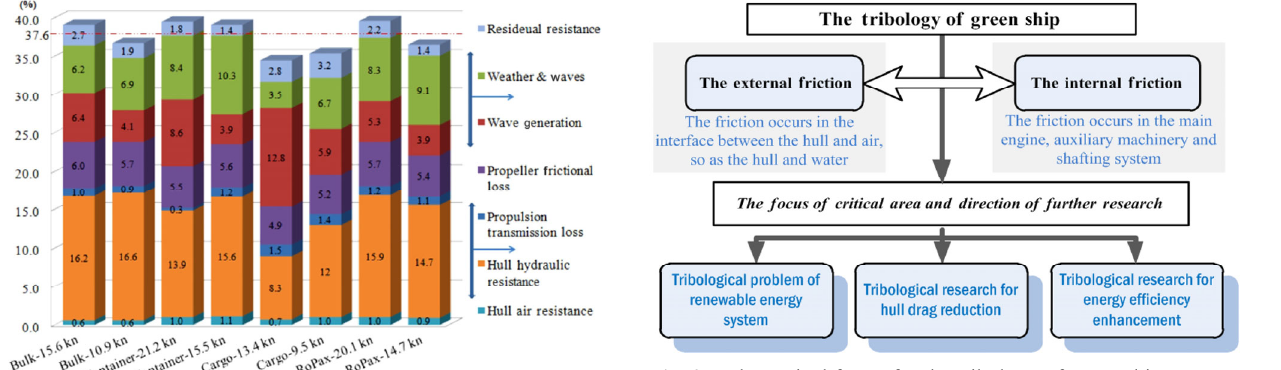
Fig. 2 Theoretical frame for the tribology of green ship.